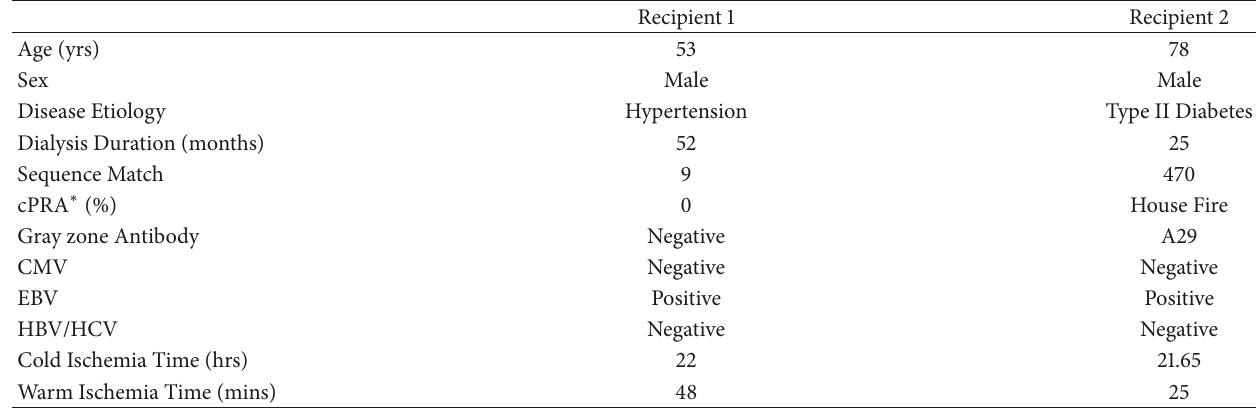
Table 2: Recipient